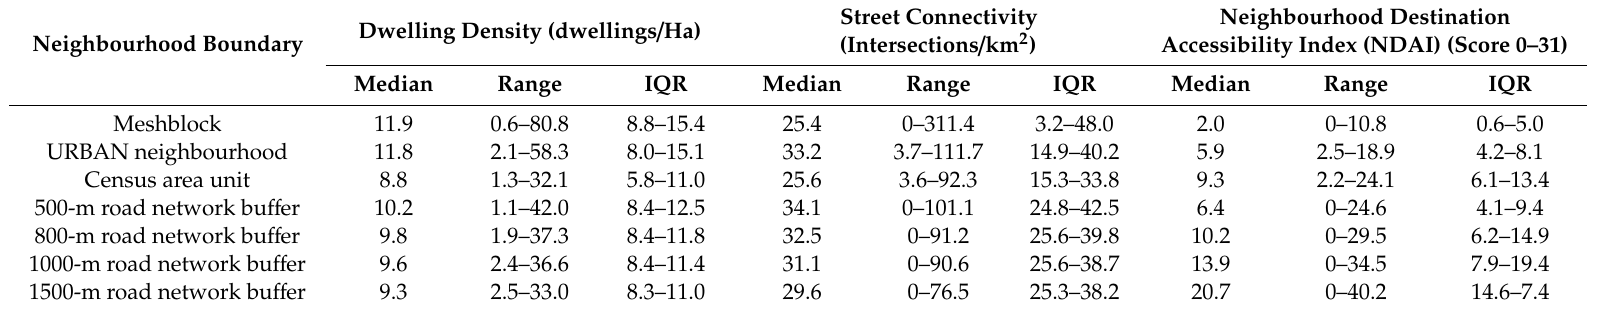
Table 4. Built environment descriptive statistics for neighbourhood boundaries ( n = 1989 adults).